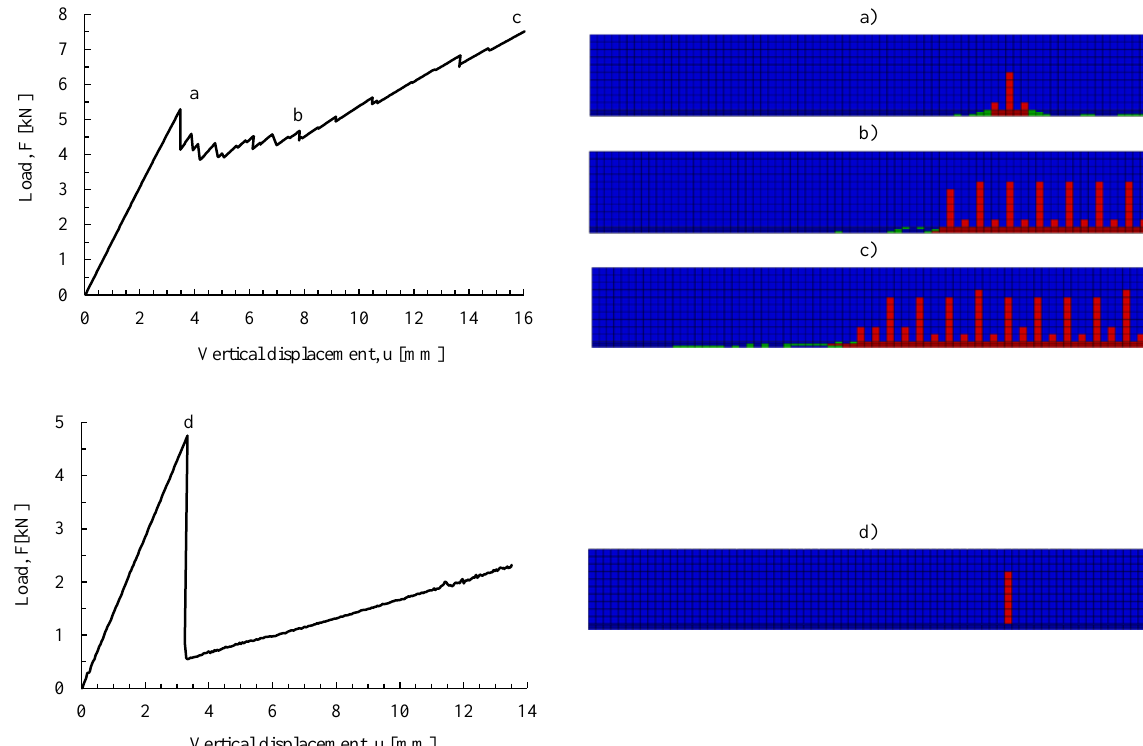
Fig. 4 Load vs. vertical displacement diagrams of the S Dur (top left side) and S Flex (bottom left side) beams, obtained from the ABAQUS using a smeared crack model, as well as the crack pattern a), b), c) and d) at different phases (right